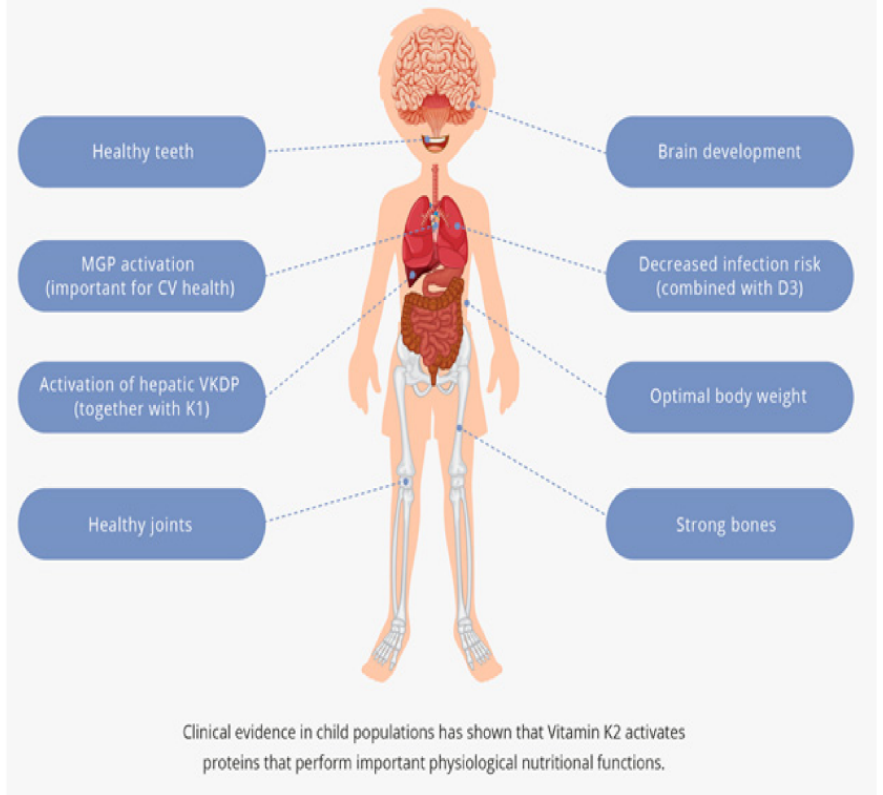
Figure 1. Vitamin K2 is important for many biological